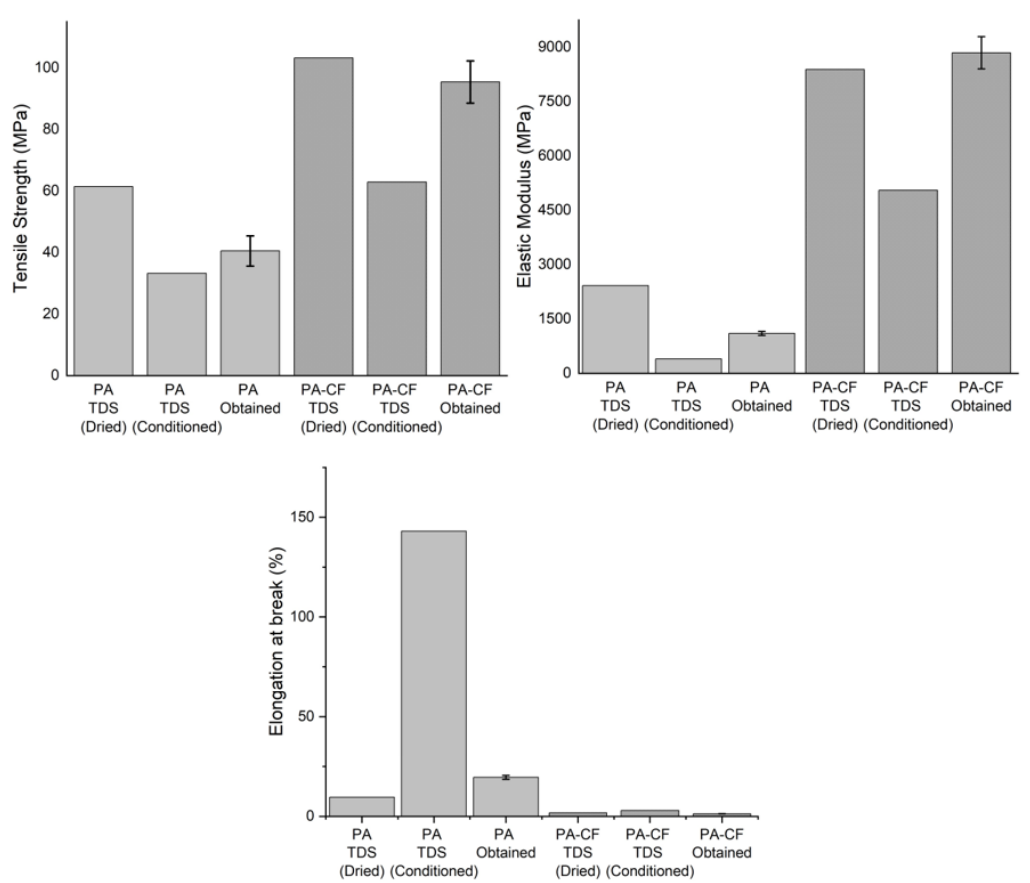
Figure 6. Comparison of mechanical properties obtained by this study and the TDS (the 0° raster